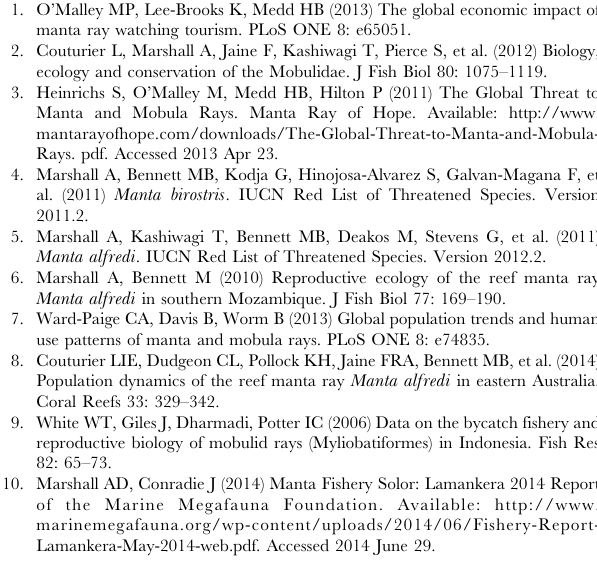
Table S1 Manta Matcher ID and encounter codes for key individuals displaying long-range